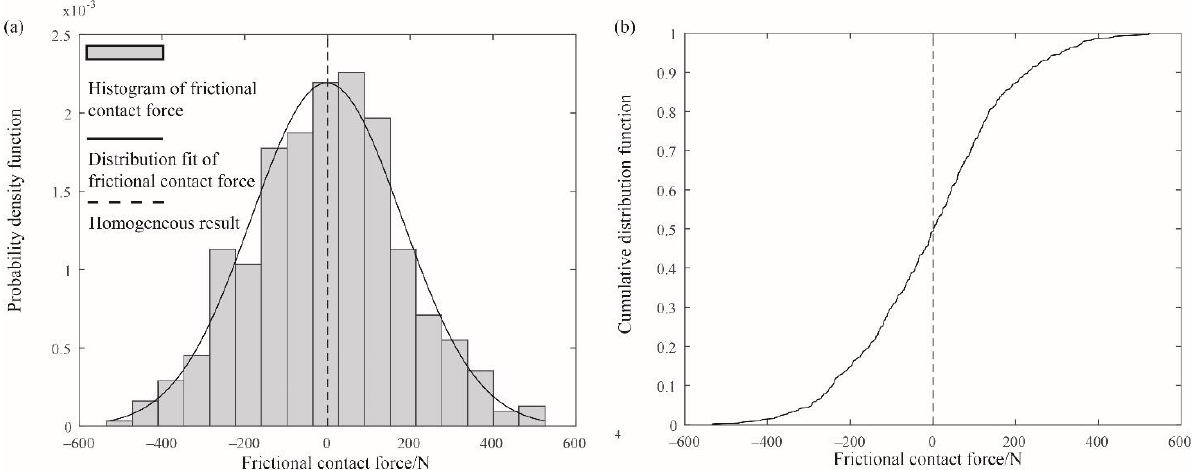
Figure 10. PDF ( a ) and CDF ( b ) of the normal contact force at the middle bottom point A of the elastic block from 500 realisations when the coefficient of friction is 0.3.